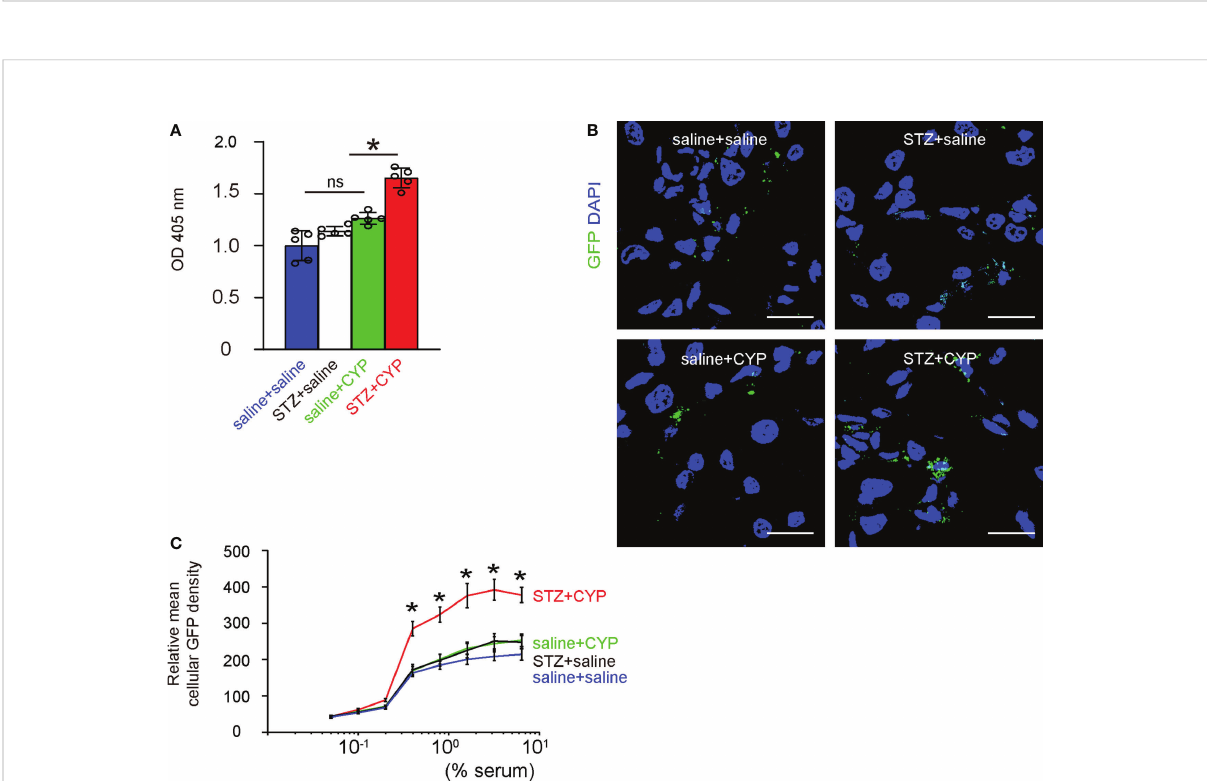
FIGURE 6 Diabetes increases phagocytosis of macrophages from in fl ammatory bladder. (A) A phagocytosis assay that analyzes 30 minutes ’ zymosan intake. (B, C) Analysis of the intake of GFP+ bacteria, shown by representative images (B) , by the mean cellular GFP density of macrophages (C) . *p<0.05. Scale bars are 15µm. ns, no signi fi cance.